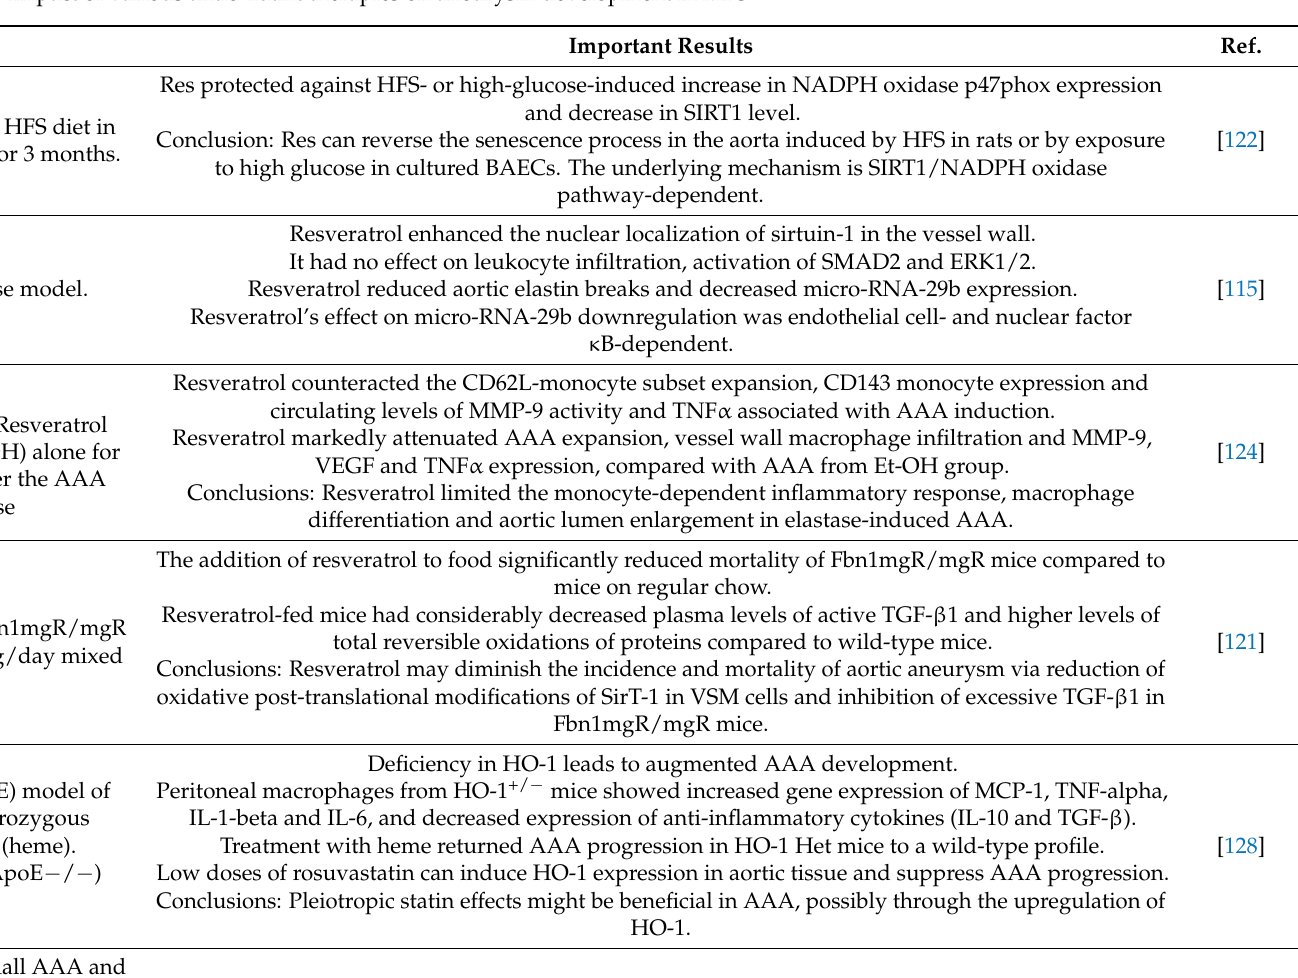
Table 1. Impact of various antioxidant therapies on aneurysm development in